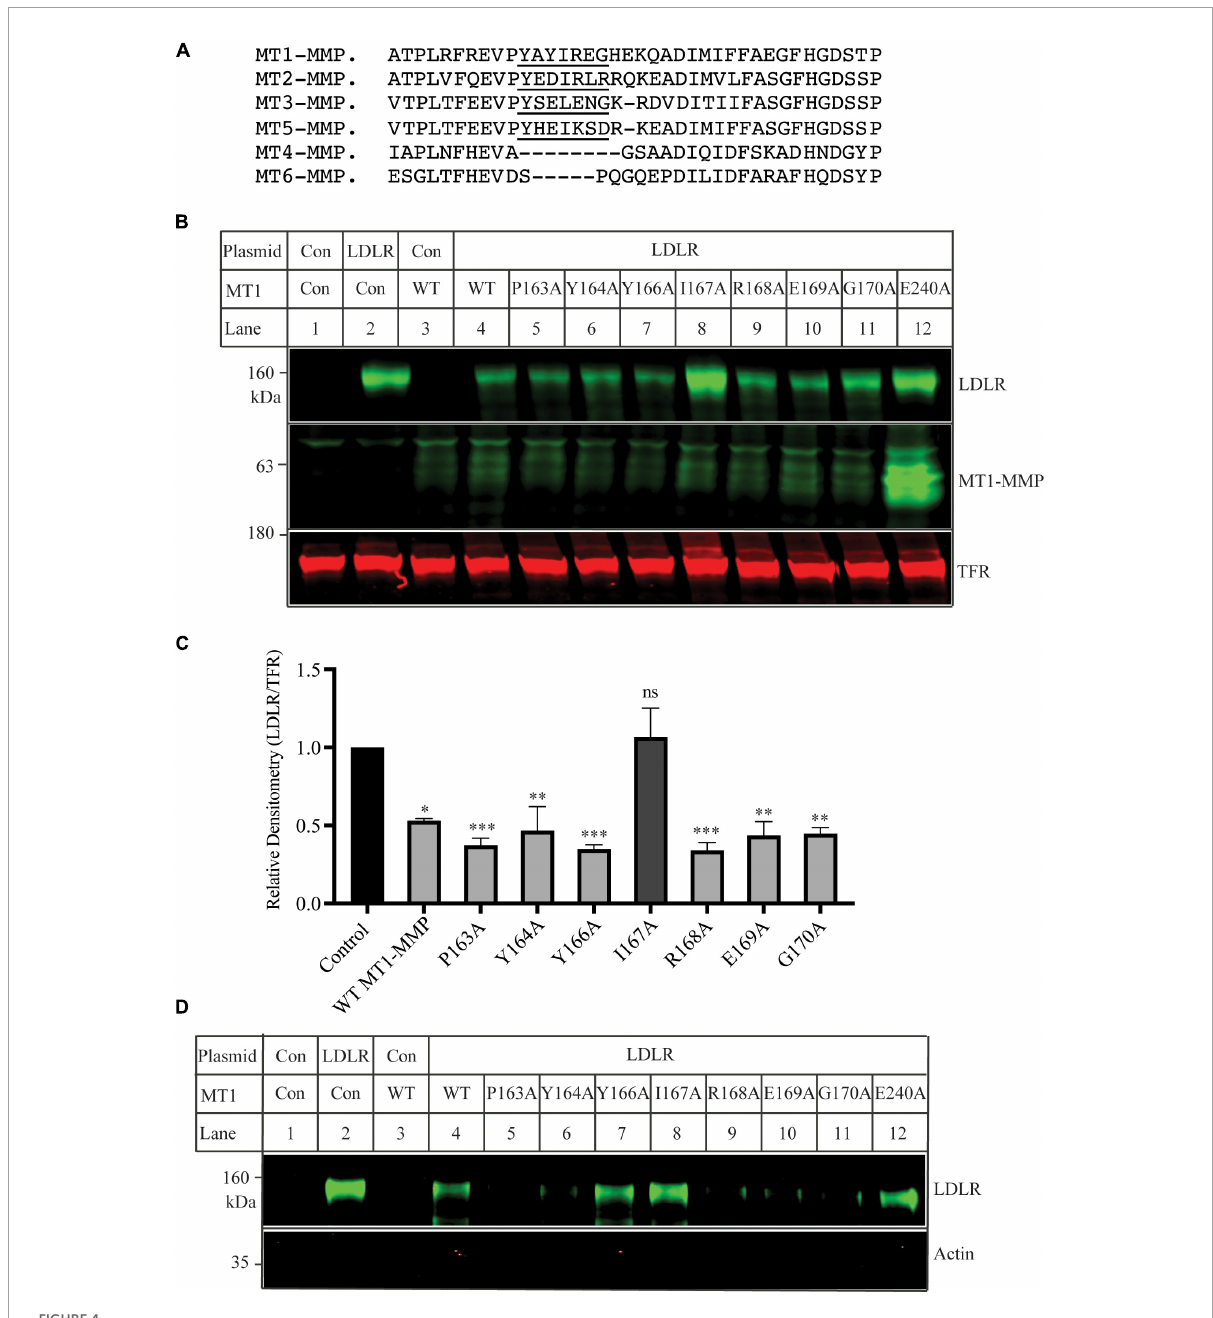
FIGURE4 Mutational analysis of the MT-loop (A) Alignment of partial sequence of different MT-MMPs. The alignment was performed using Multiple Alignment (Fast Fourier Transform (MAFFT) FFT-NS-I, v7.429). MT1-MMP: NP_004986; MT2-MMP: NP_002419.1; MT3-MMP: NP_005932; MT5-MMP: NP_006681. MT4-MMP: NP_057239. MT6-MMP: NP_071913. The MT-loop was underlined. (B ) Immunoblotting and (C) quantification. Plasmid DNA containing the wild-type LDLR was co-transfected with an equal amount of empty vector (Con), the wild-type, or mutant MT1-MMP into HEK293 cells using Lipofectamine 3000. 48 h later, whole cell lysate was prepared and applied to immunoblotting. LDLR and MT1-MMP were detected by a mouse monoclonal anti-LDLR antibody, HL-1, and a rabbit monoclonal anti-MT1-MMP antibody (abcam, ab51074), respectively. TFR, transferrin receptor (TFR), was recognized by a mouse anti-TFR monoclonal antibody. (D) Biotinylation. HEK293 cells were co-transfected with WT LDLR and WT or mutant MT1-MMP using Lipofectamine 3000. 48 h after, the cells were subjected to biotinylation and then immunoblotting using a mouse anti-LDLR (HL-1) and a mouse anti-actin antibody. Similar results were observed in three different experiments. Representative images were shown (B and D). Densitometry was determined by a Li-Cor Odyssey Infrared Imaging System. Relative densitometry was defined as the ratio of the densitometry of LDLR to that of TFR at the same condition. Values were mean ± S.D. of ≥ 3 experiments. The significant difference between two groups (wild type or mutant MT1-MMP vs. the Control)